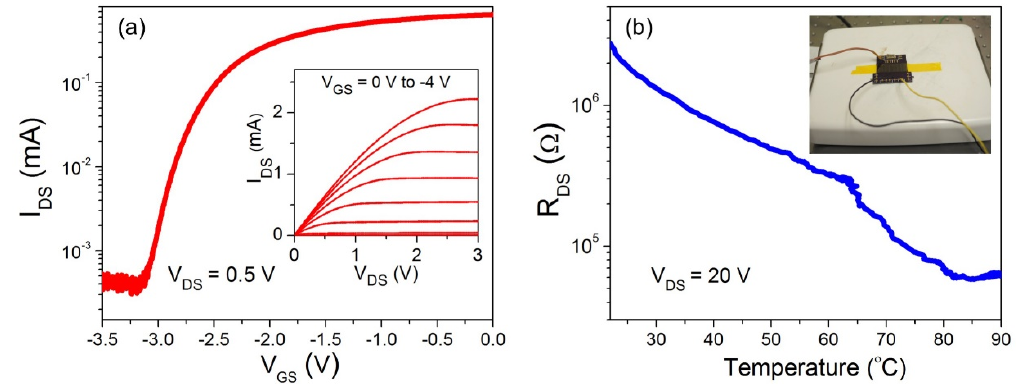
Figure 2. ( a ) I DS - V GS characteristics of the AlGaN / GaN HFET. The inset shows I DS - V DS characterization results. ( b ) Temperature effects on the VO 2 thin film resistance. A photo of the temperature characterization setup, with the hot plate, the biasing signal lines and the thermo-couple, is shown in the inset.